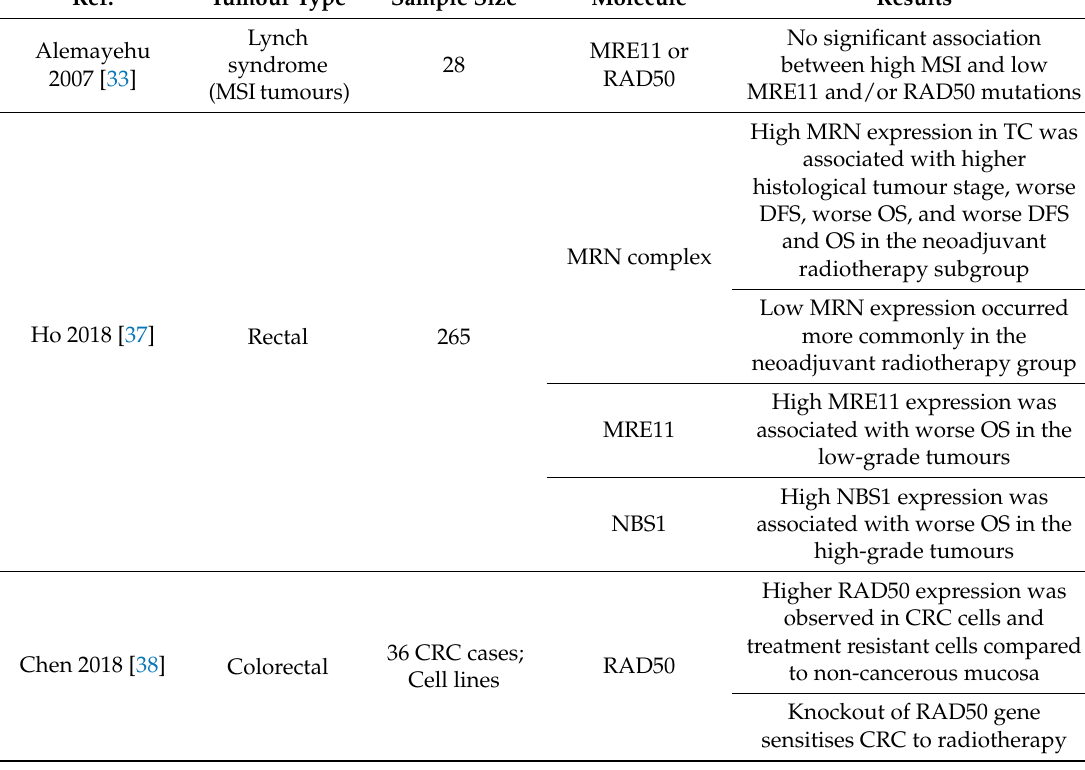
Summary of the correlation between high MRN complex expression and poorer clinicopathological outcomes in colorectal cancer.